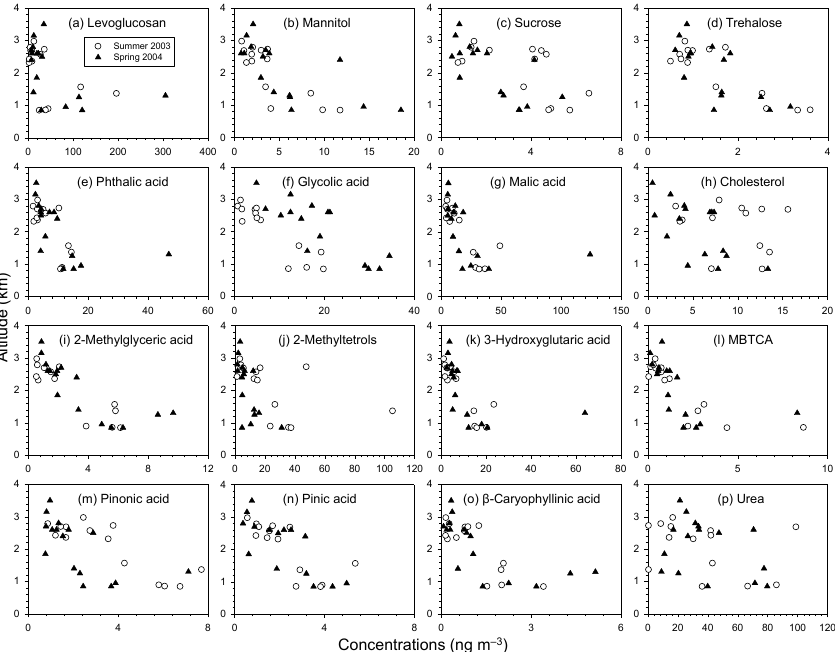
Fig. 8. Vertical profiles of polar organic tracers in aerosol particulate matter (PM 10 ) collected during two aircraft campaigns over central China in summer 2003 and spring 2004,